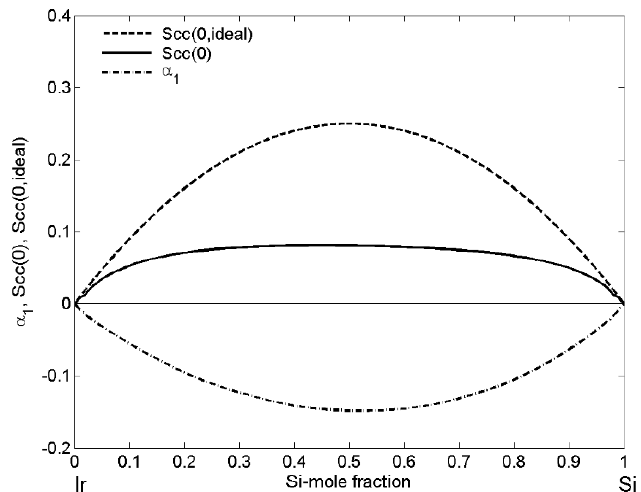
Figure 4. Concentration fluctuations in the long-wavelength limit ( S cc ( 0 ) and S cc ( 0, id )) and chemical short-range order parameter ( α 1 ) vs. bulk composition ( x Si ) of liquid Ir-Si alloys calculated for T = 1873 K.